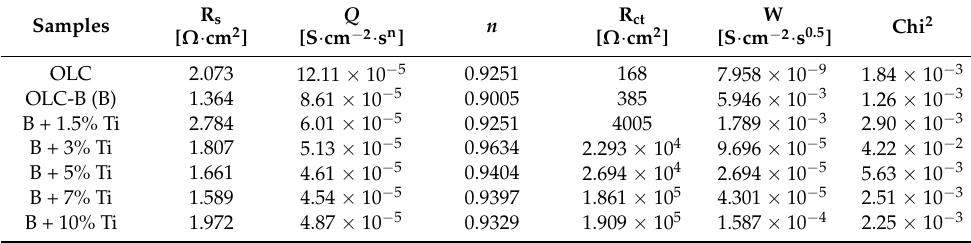
Table 4. Calculated values of the circuit elements for modeling of metallic samples in test solution.